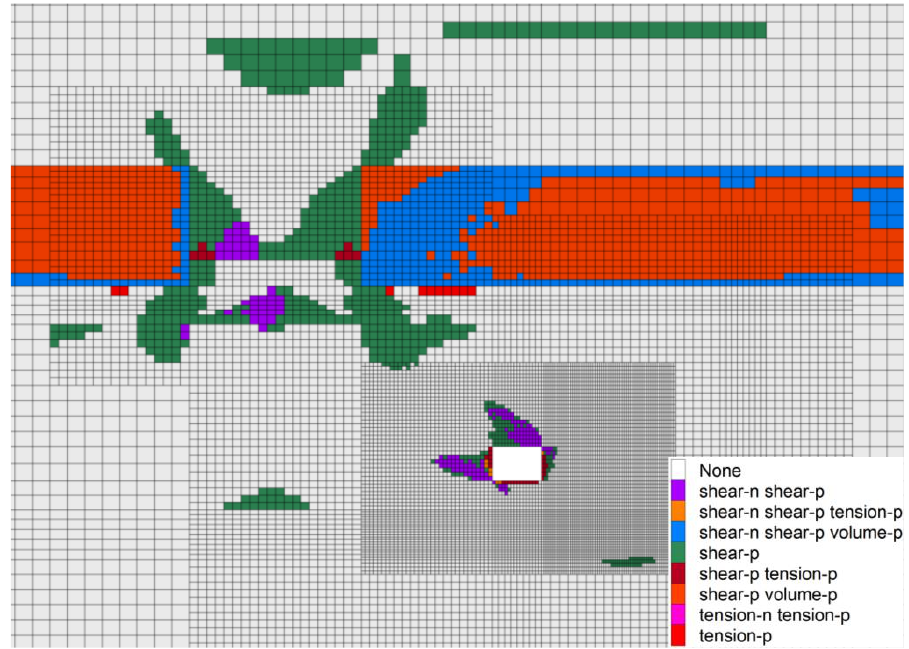
Figure 14. Plastic zone distribution cloud map when the roadway excavation along the floor.